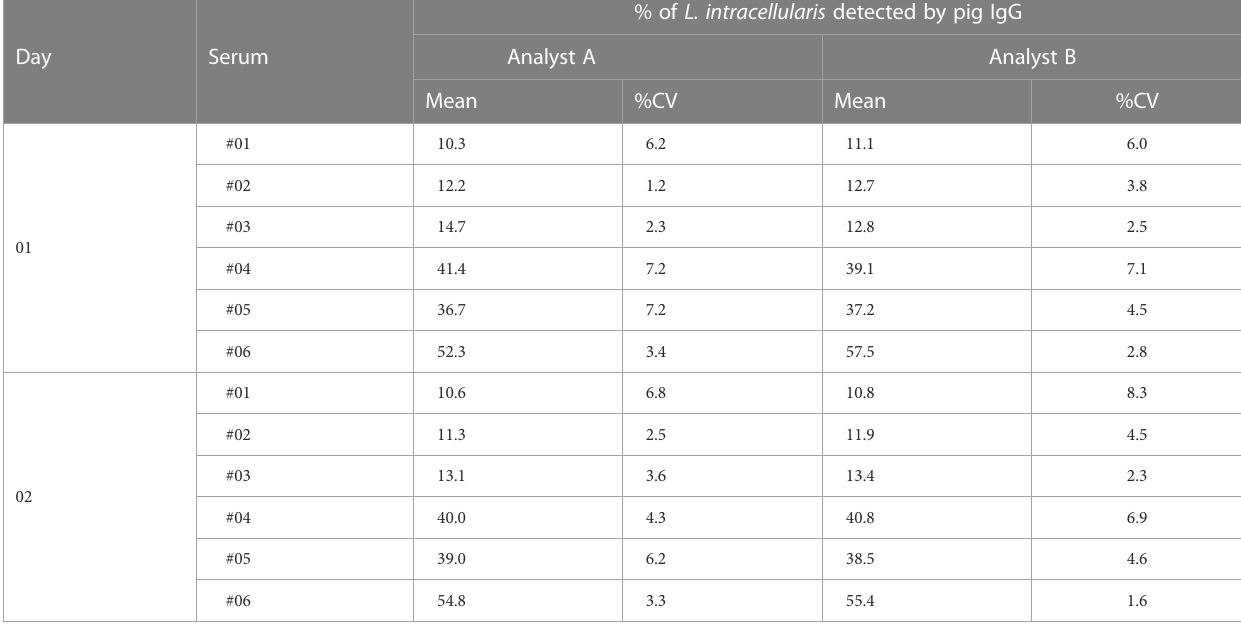
TABLE 2 Precision and reproducibility analysis of pig serum by different analyst at two different